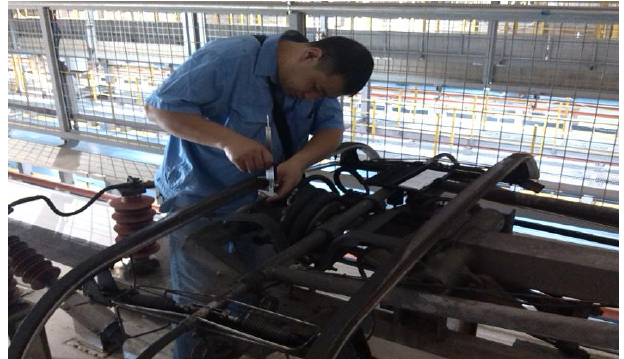
Figure 1. Traditional detection method.